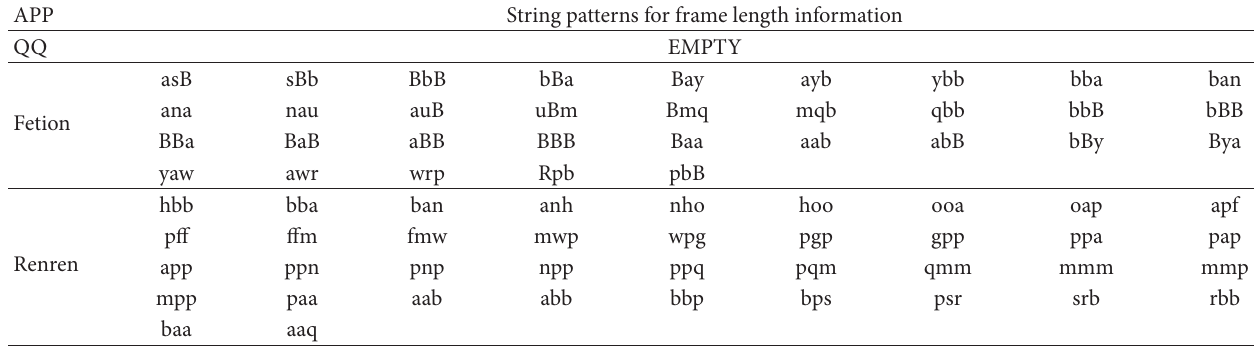
Table 7: String patterns of frame length information for three applications.